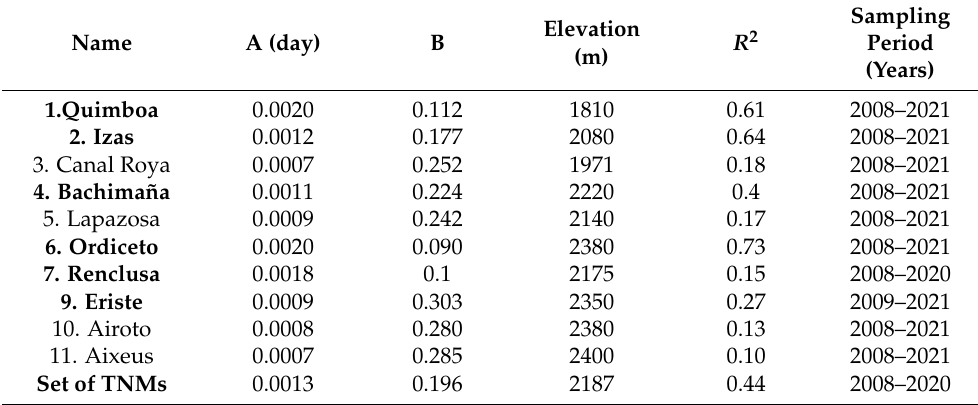
Table 6. SDEN intra-annual time dependence for automatic measurements. Bold letters are used for selected sites for the Set of